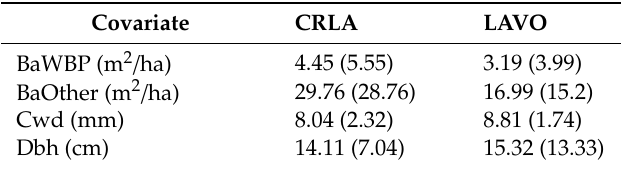
Table 3. Summary statistics of unstandardized covariates included in each of the five generalized linear mixed-e ff ects models in both Crater Lake (CRLA) and Lassen Volcanic (LAVO) National Parks. The values below represent averages and standard deviations for each covariate across all plots ( n = 30) in each park.